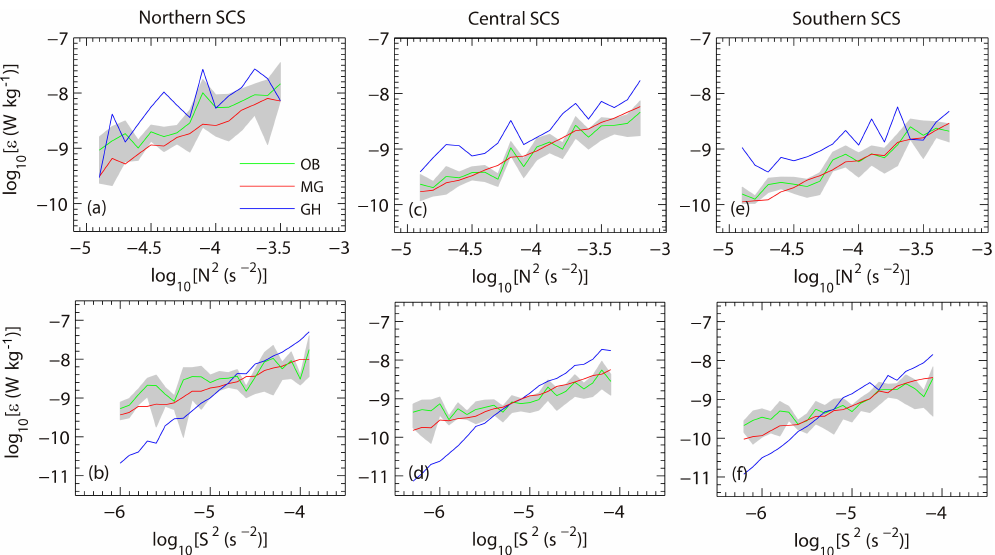
Figure 9. Average dissipation rate calculated in bins of buoyancy frequency squared ( N 2 ) and shear variance ( S 2 ) for the northern SCS (a– b) , central SCS (c–d) , and southern SCS (e–f) . The green, red, and blue curves are the results of the observation, MG model, and GH model, respectively. The grey shading indicates the 95% bootstrapped confidence interval for the observed dissipation rates.